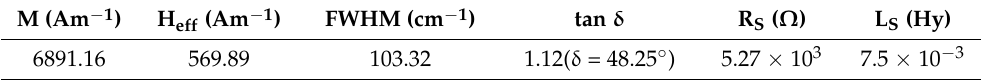
Figure 3. Correlation study in the Fe–Si steel/iron oxide structure, whereby the Raman spectra of the iron oxide thin-film reveals hematite phase and M-H loop for the iron oxide-coupled Fe–Si steel foil exhibited exchange coupling. Table 2. Correlation parameters evaluated in the α -Fe 2 O 3 /Fe–Si steel